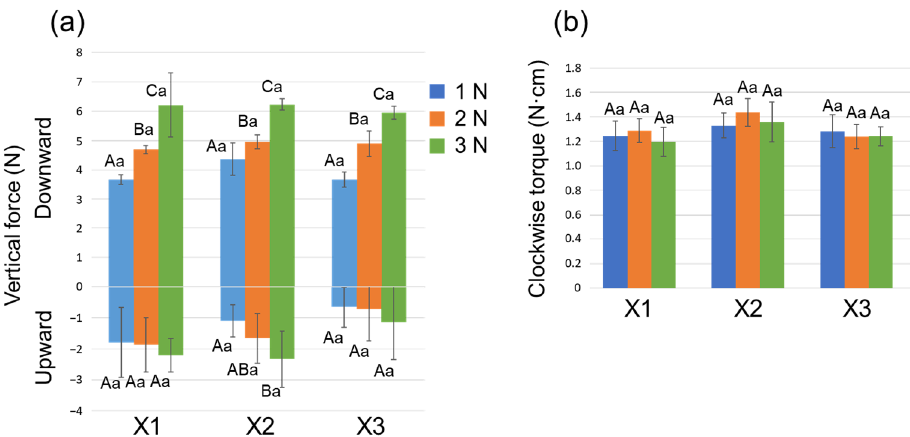
Figure 4. ( a ) Maximum upward and downward vertical force values and ( b ) maximum torque values detected during PTN instrumentation (X1, X2 followed by X3) with different downward loads. Data are the mean and standard deviation ( n = 10 in each group for each instrument). Values with different capital letters in the same instrument and values with different small letters at the same downward load are significantly different ( p < 0.05).